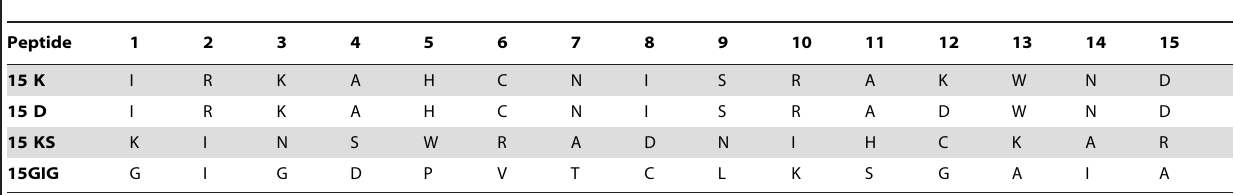
Table 2. Sequences of synthesized peptides.